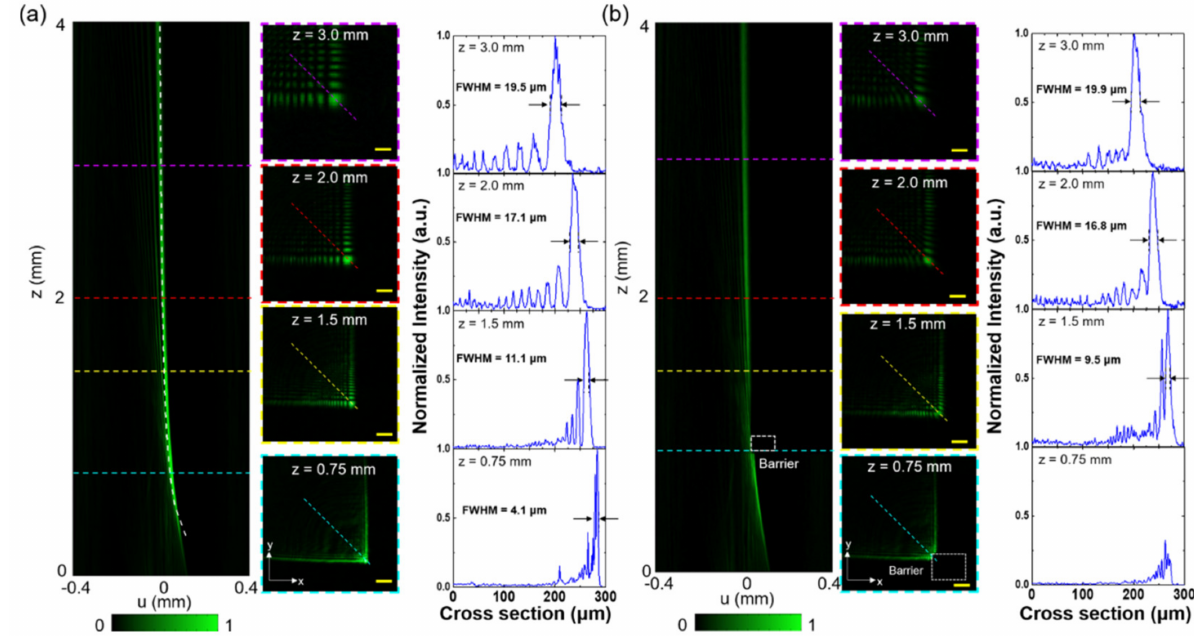
Figure 3. Experimental verification of propagation properties for a vertically accelerated 2D Airy beam generated by a cubic-phase metasurface. Measured intensity distribution for propagation trajectory of the vertically accelerated 2D Airy beam in free space ( a ) without or ( b ) with a barrier at z = 0.5 mm at 532 nm. The theoretical propagation trajectory is indicated as the white dashed line. The cross-sectional normalized intensity distributions of the propagation profile of a vertically accelerated 2D Airy beam. The corresponding cross-sectional image of intensity distribution at propagation positions of z = 0.75, 1.5, 2.0 and 3.0 mm, respectively. Scale bar: 25 µ m. The intensity profiles of the main lobe of the beam along u-direction (dash line) are at z = 1.5, 2.0, and 3.0